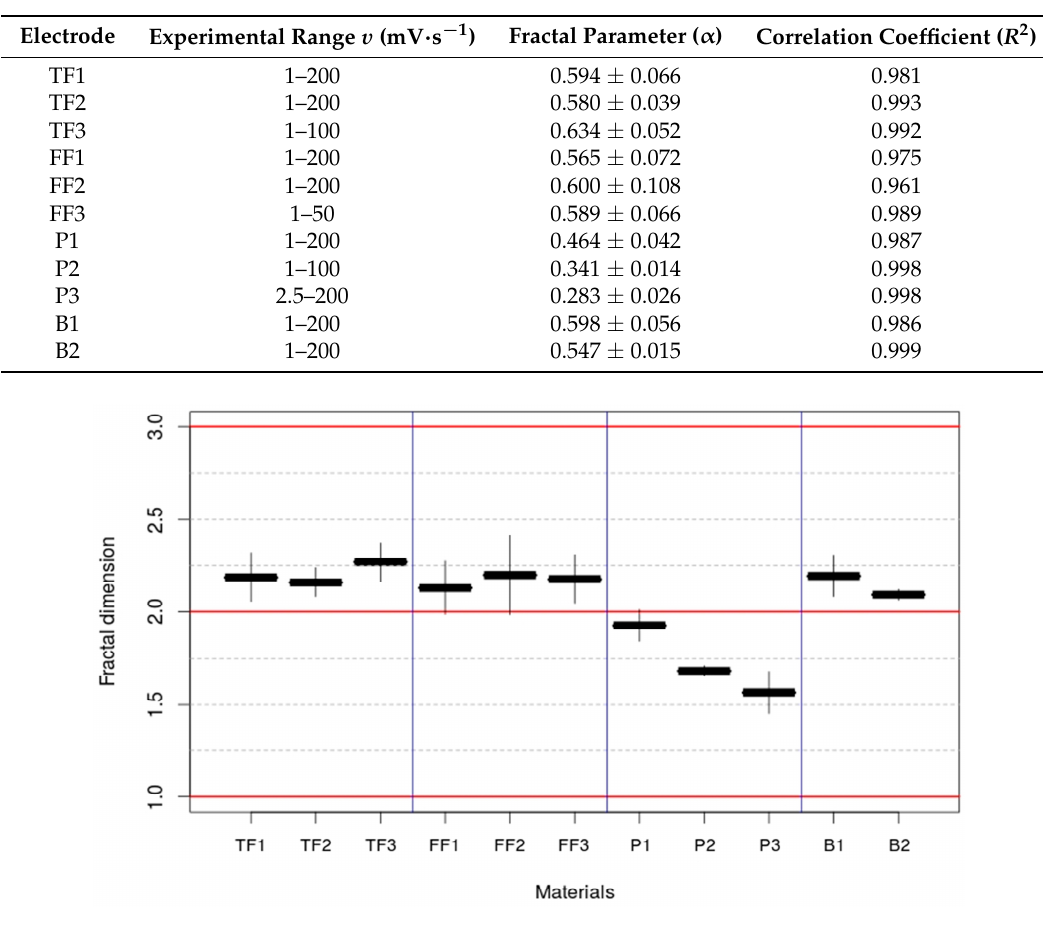
Figure 6. Fractal dimension of the electrodes tested. The values corresponding to Euclidean integer dimensions are shown as red solid lines.